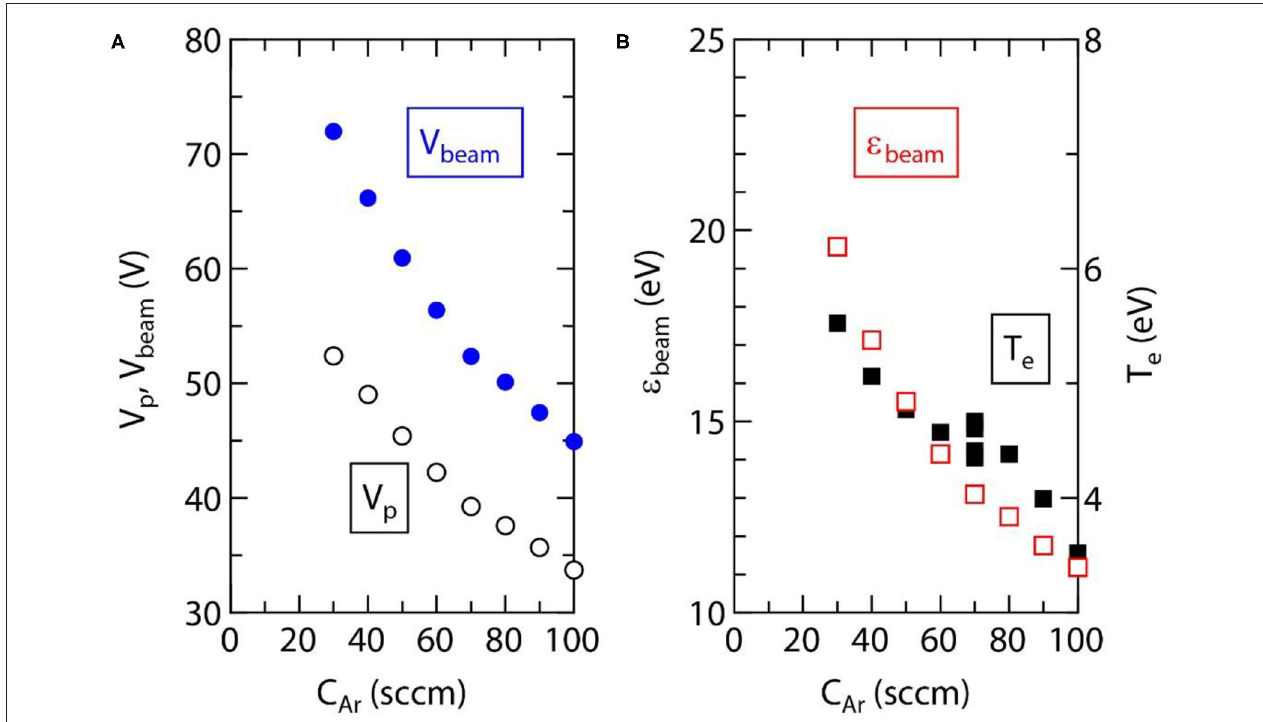
FIGURE 9 | (A) Plasma potential V p (open circles) and beam potential V beam (filled circles) as functions of the gas flow rate C Ar , where these potentials are obtained from the Gaussian fitting curves (not shown here) of the measured IEDF at z = 25cm. (B) Calculated ion beam energy ε beam (open squares) from the data in (A) and electron temperature T e (filled squares) taken at z = 10cm as functions of C Ar